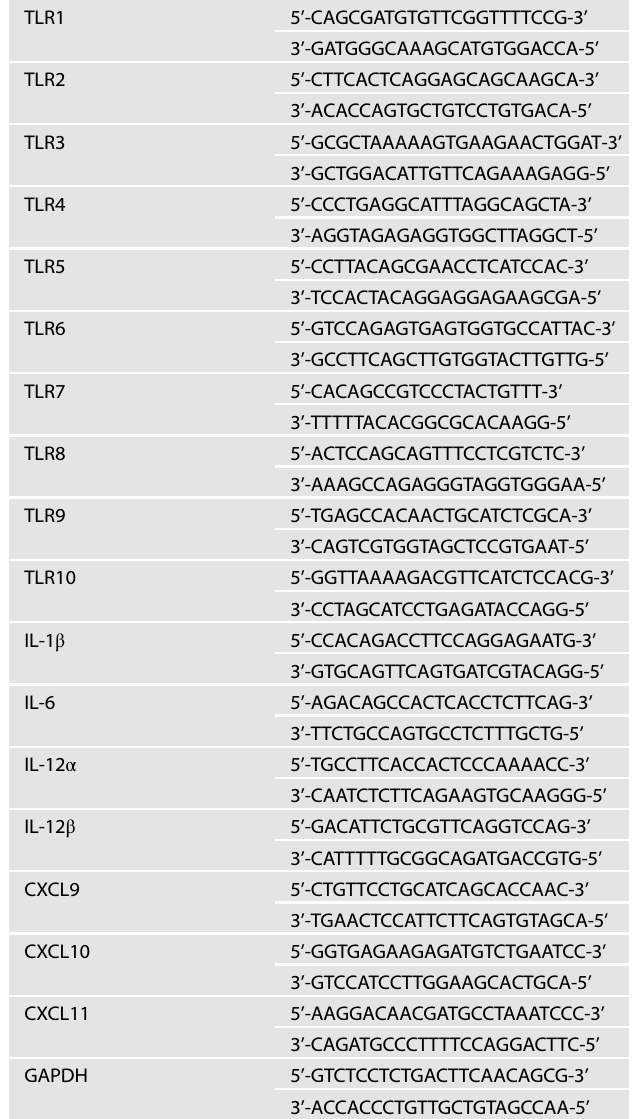
Table 1. Primer sequences of TLR1-10, IL-1 β , IL-6, IL-12 α , IL-12 β , CXCL9-11 and